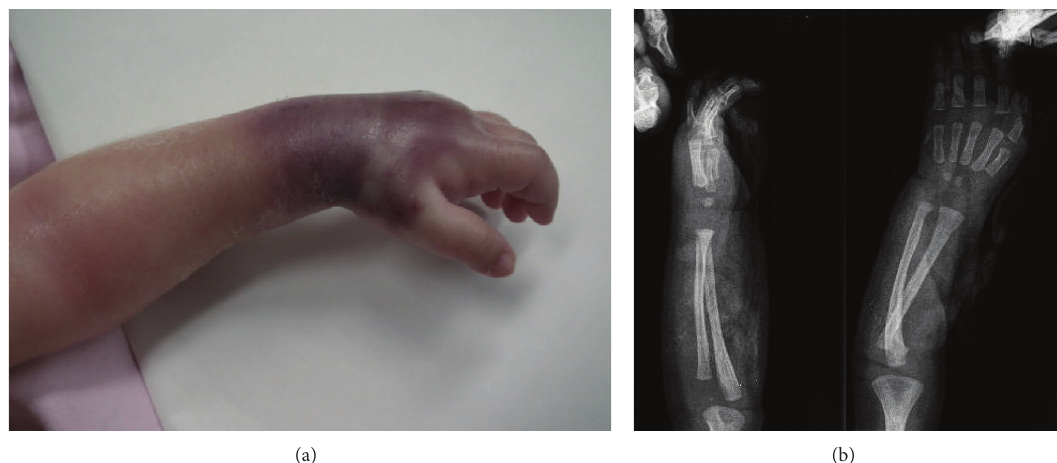
Figure 1: (a) Image showing the left hand and the forearm of the patient. Remarkable edema, swelling extending through the forearm can be observed. (b) X-ray of the patient shows a cloudy image indicating a considerable accumulation of contrast agent of both the forearm and the hand.